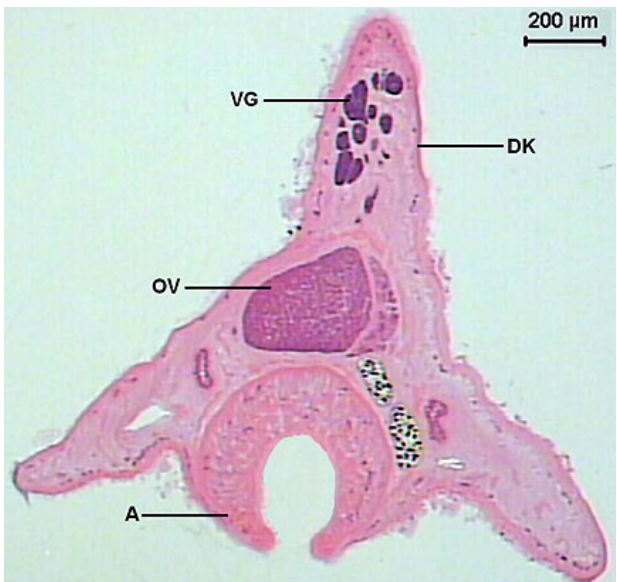
Figure 2. Transversal section of Sticholecitha serpentis . VG – viteline glands, DK – dorsal keel, OV – ovary, A – acetabulum. HE.